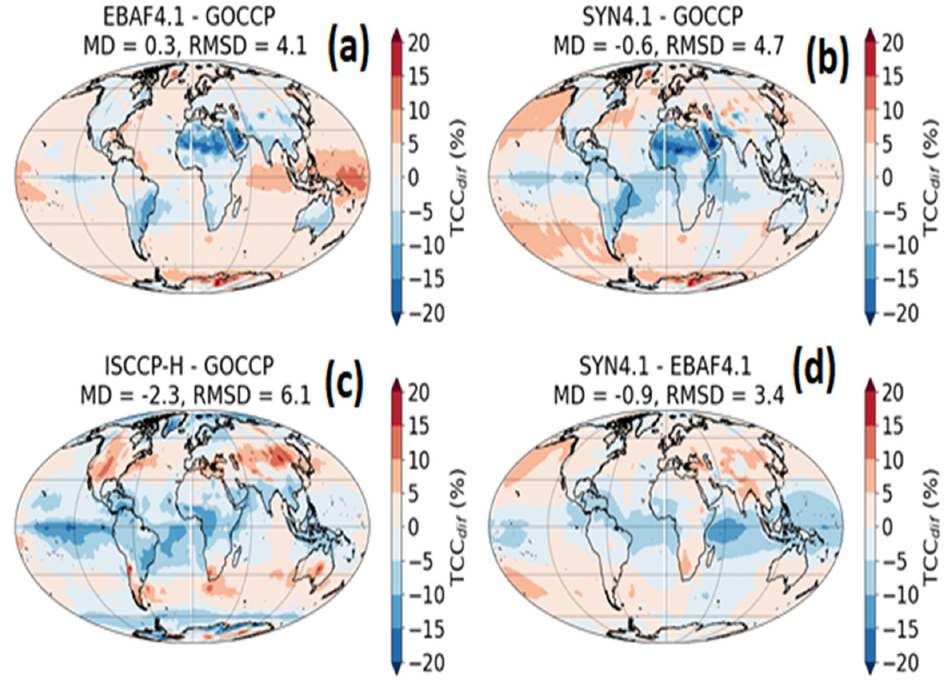
Figure 5. Global maps of bias (x-GOCCP) in annually averaged TCC and root mean square deviation (RMSD) where x represents EBAF4.1 ( a ), SYN4.1 ( b ), ISCCP-H ( c ), and EBAF4.1 –SYN4.1 ( d ).